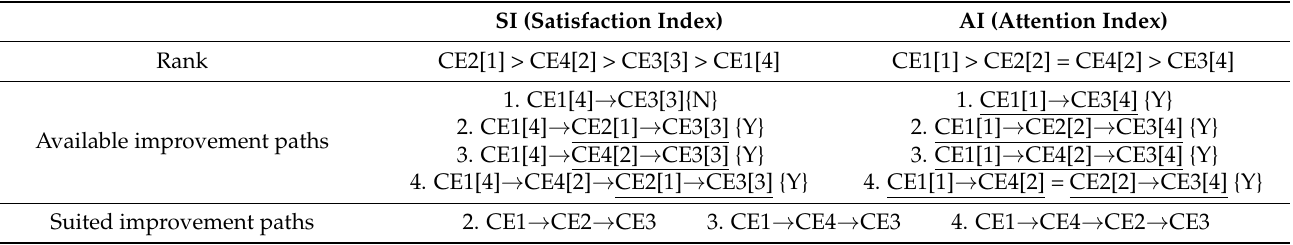
Table 8. The suited improvement paths of the CE (concept and evaluation)